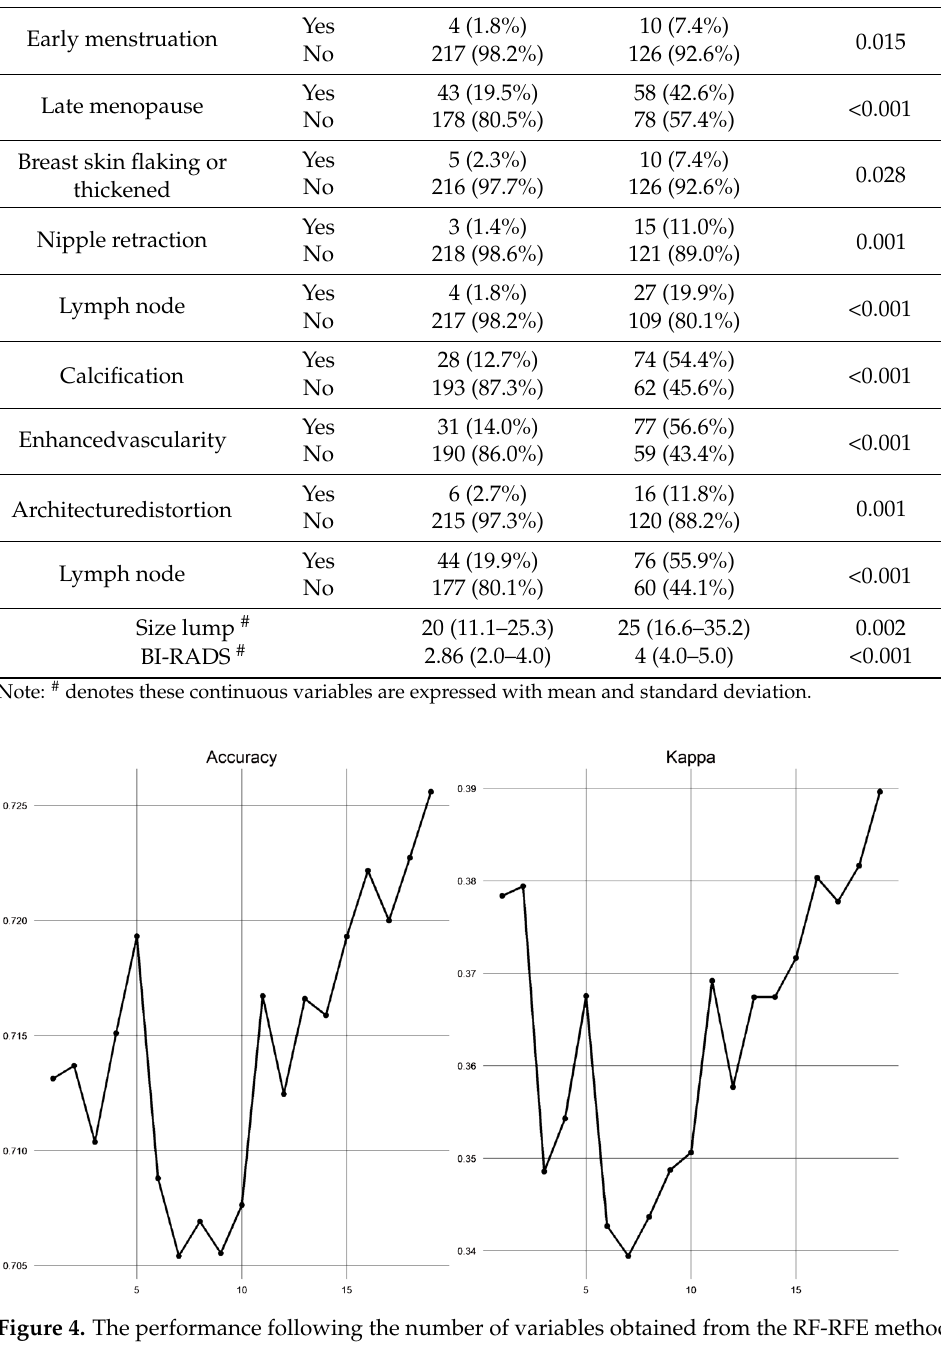
Table 3. The correlation between clinical variables with outcomes which are benign or malignant. Variables Benign Malignant p -Value Early menstruation